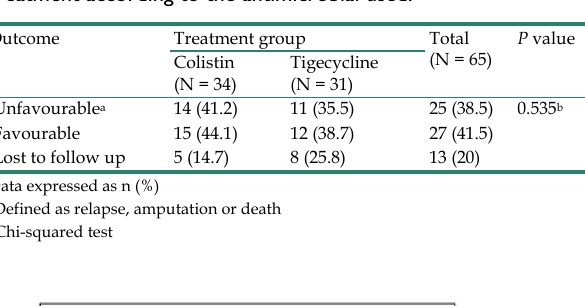
Data expressed as n (%) a Patients who did not present with signs of recurrent infection were considered to have achieved remission. b Fisher’s exact test was used Table 4. Categorised distribution of outcomes after 12 months of treatment according to the antimicrobial used.